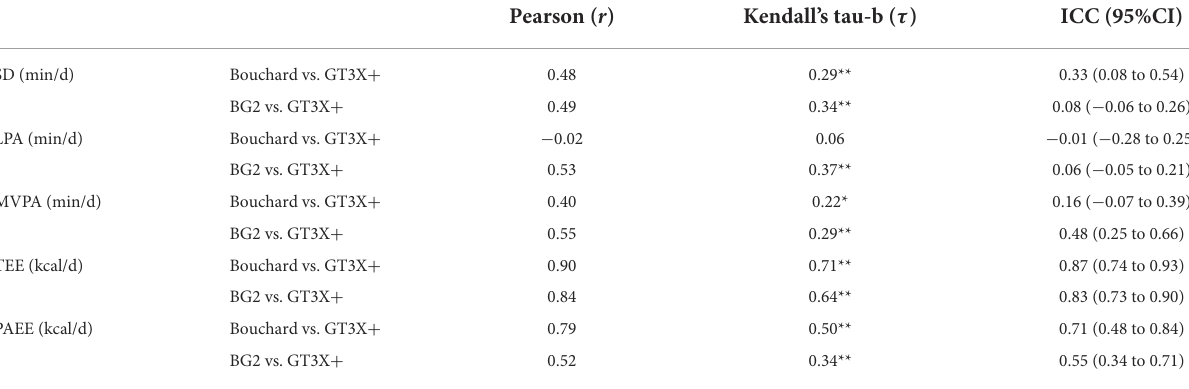
TABLE 1 Correlation and agreement of PA parameters in BG2 and Bouchard compared with GT3X +